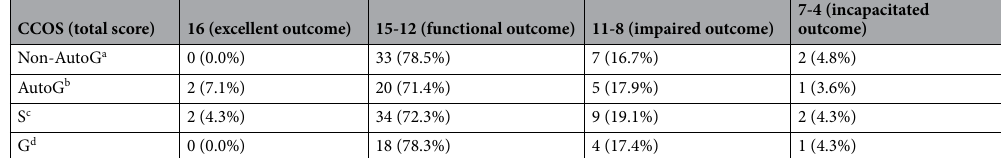
Table 2. Long-term follow-up in Chicago Chiari Outcome Scores (CCOSs) depend on kind of grafts and methods of graft fixation. 1 Non-autologous graft, 2 Autologous graft, 3 Graft fixed with sutures, 4 Graft fixed with